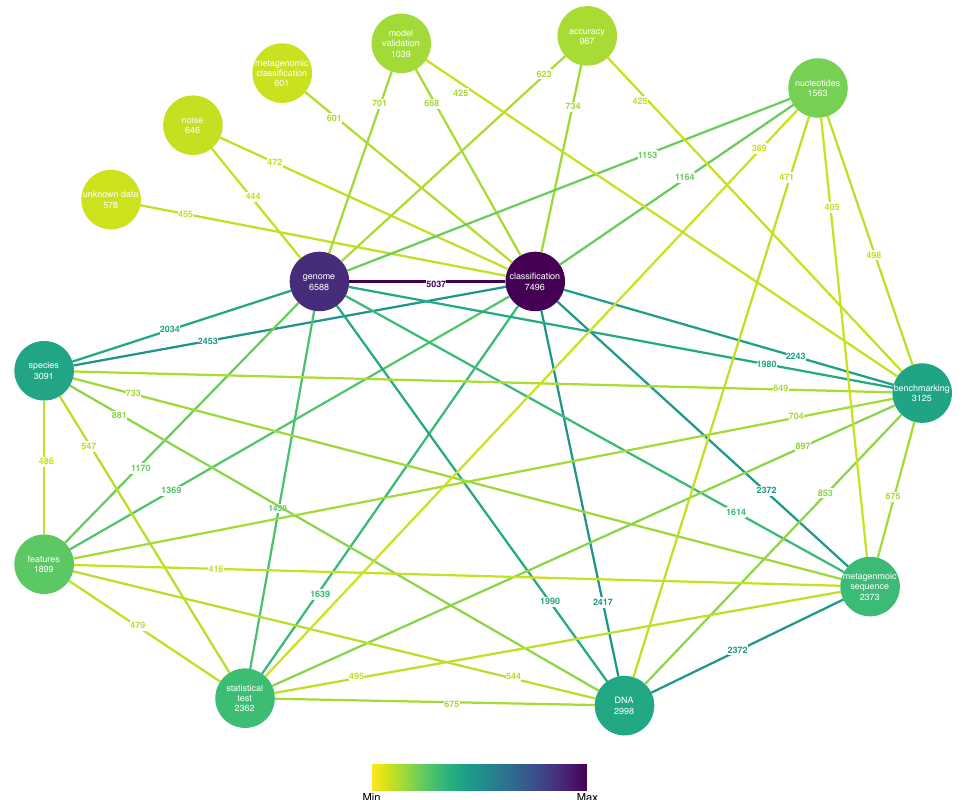
Figure 9. Number of relevant articles per property and number of co-occurrences of properties in relevant